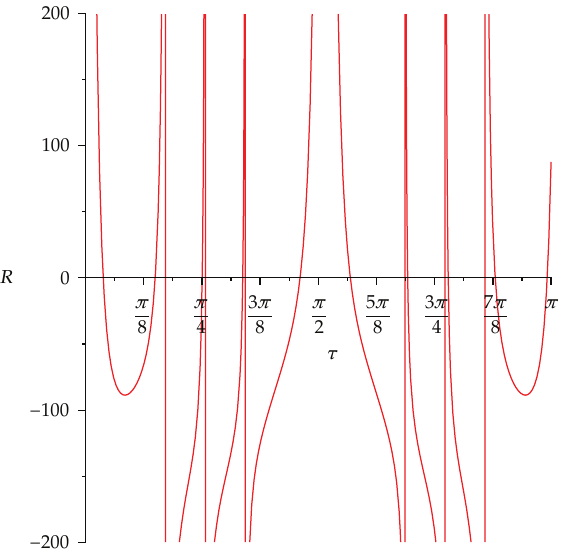
Figure 20: The evolution of the R with respect of the cosmic time τ for (cid:2) 4.15 (cid:3)